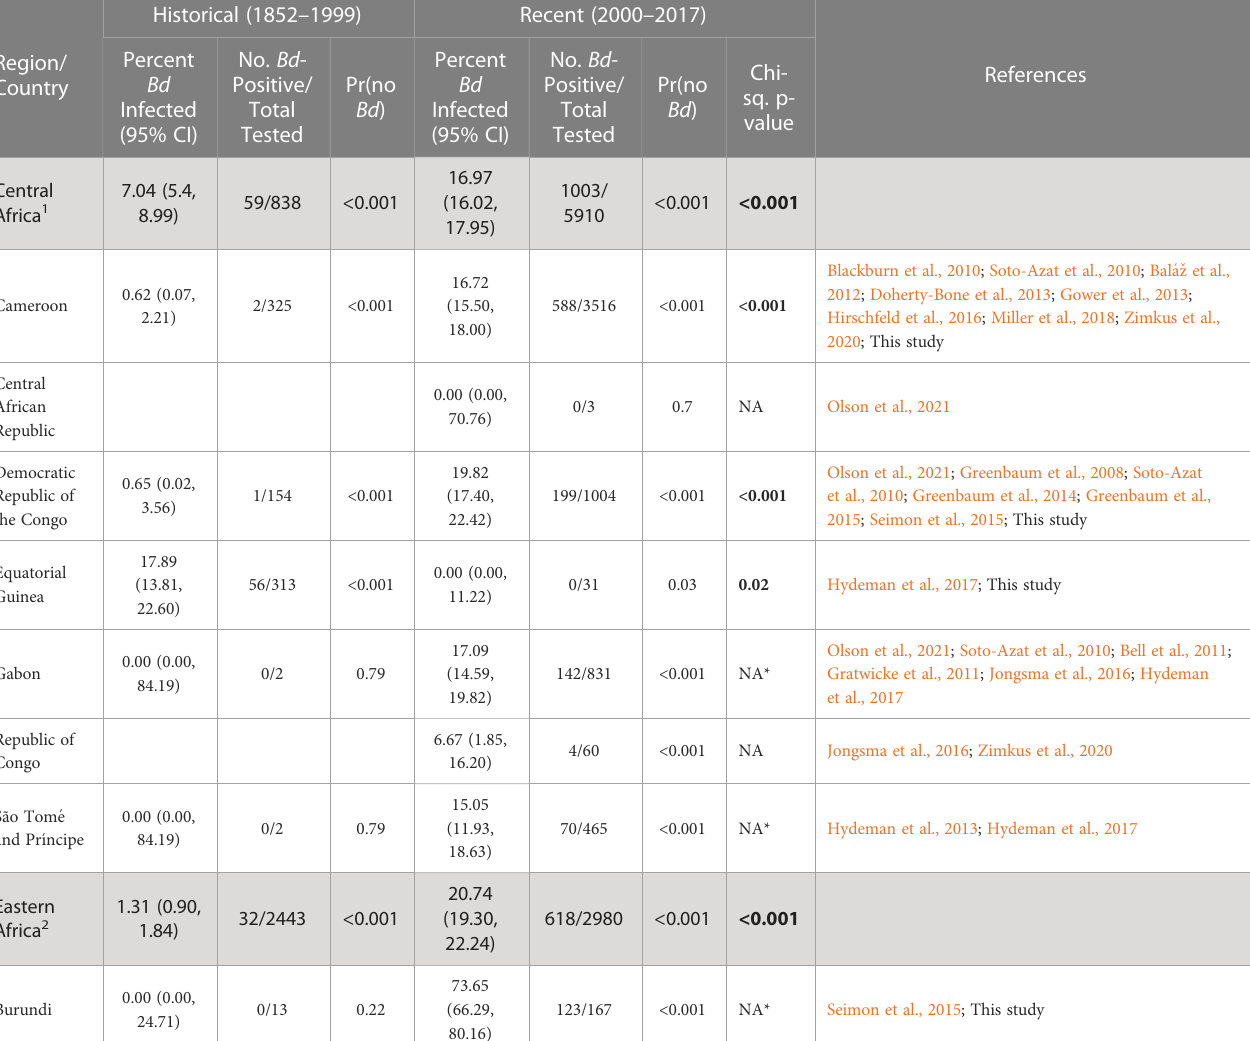
TABLE 1 Compiled historical and recent frequency of Batrachochytrium dendrobatidis (Bd) occurrence by country and region.